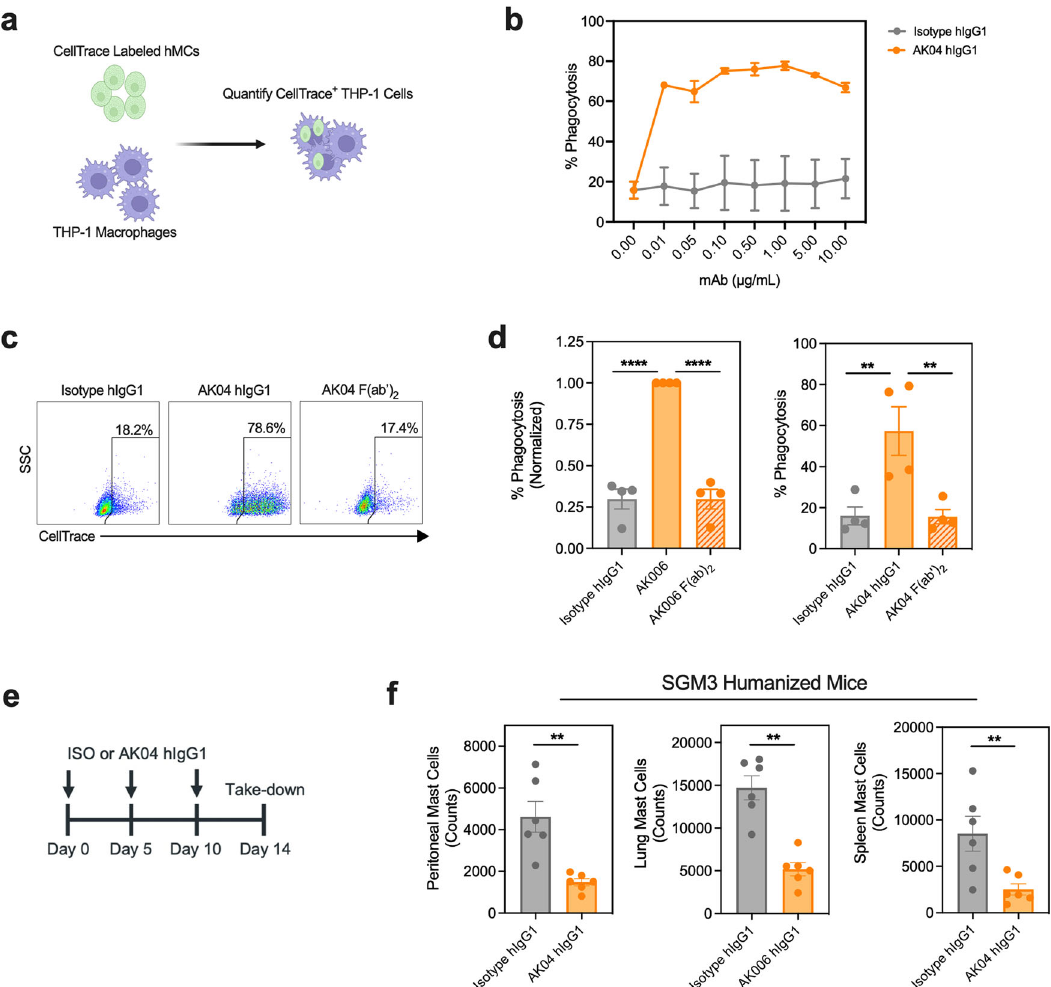
Fig. 6 The Siglec-6 mAb AK04 reduces human MCs via antibody-dependent cellular phagocytosis. a Siglec-6 mAb antibody-dependent cellular phagocytosis (ADCP) assay using hMCs and THP-1 cells. b Percentage of phagocytosis of hMCs after 4-h incubation with the indicated concentration of AK04 (orange) or isotype control (gray). c Representative dot plots of CellTrace positive THP-1 cells and ( d ) percentage of phagocytosis after 4-h incubation with AK04 hIgG1 (orange), AK04 F(ab ’ ) 2 (hashed orange), or isotype control (gray). e Schematic of 14-day dosing study in NSG-SGM3 humanized mice with AK04 or isotype control at 5 mg kg − 1 . f MC counts from peritoneal cavity, lung, and spleen tissues at day 14 in NSG-SGM3